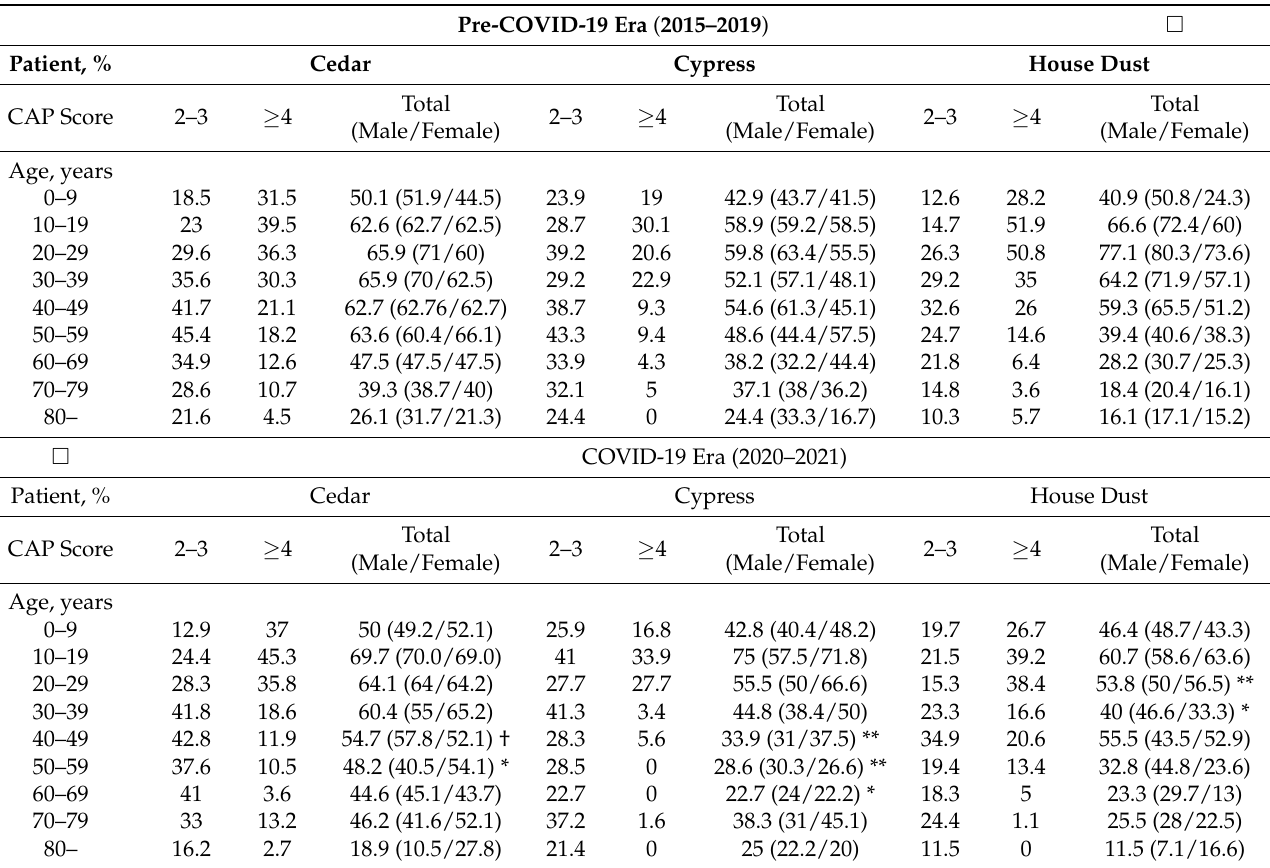
Table 3. Comparison of positive antigen rates of the patients between the two eras stratified by 10-year-old generation and CAP scores for each